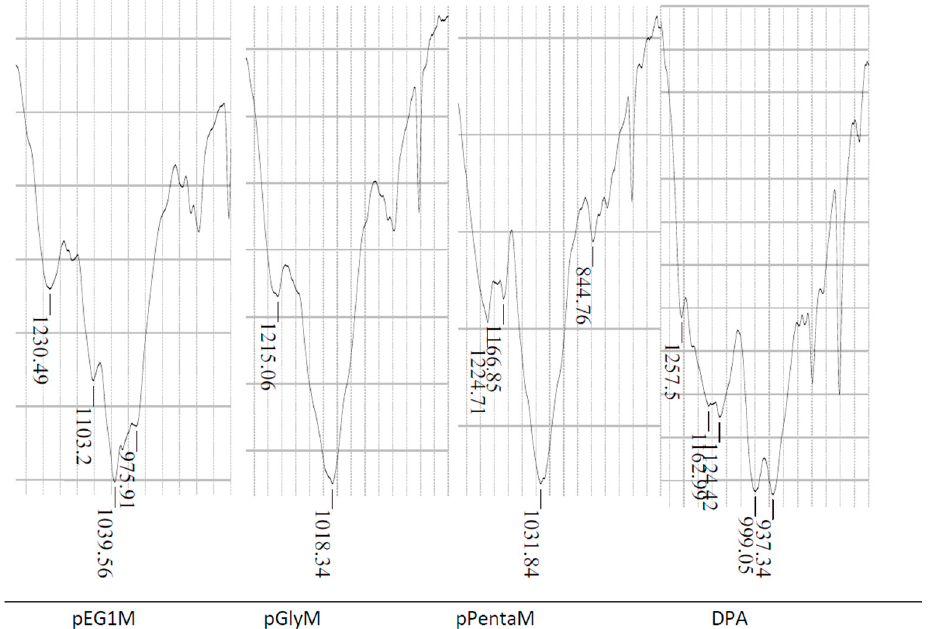
Figure 6. FTIR spectra of monoprotic (pEG1M, pGlyM, pPentaM) and diprotic (DPA).